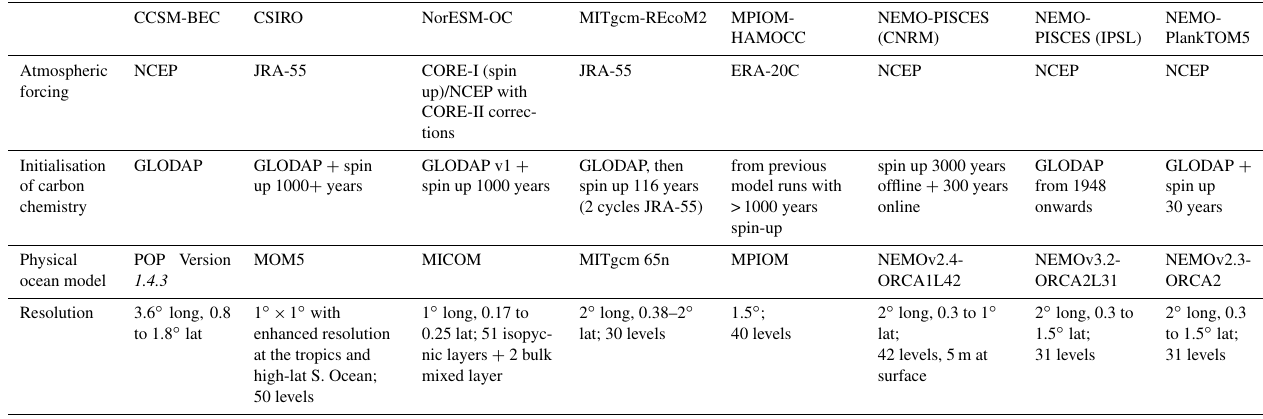
Table A2. Comparison of the processes included in the global ocean biogeochemistry models for their estimates of S OCEAN . See Table 4 for model references.